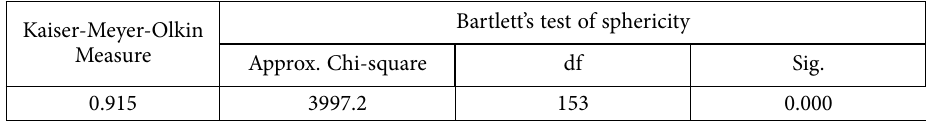
Table 2. Sampling adequacy statistics for main component analysis: KMO and Bartlett’s test Kaiser-Meyer-Olkin